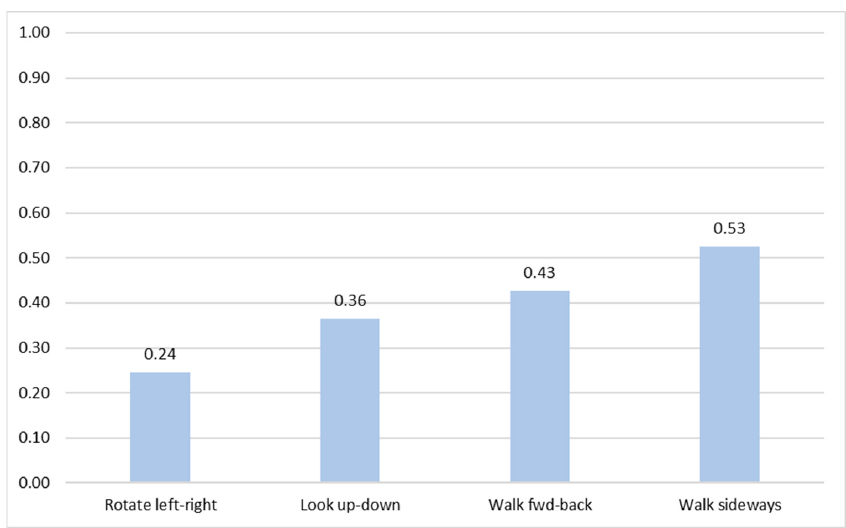
Figure 7. The agreement scores of the four navigation tasks arranged from lower to higher.